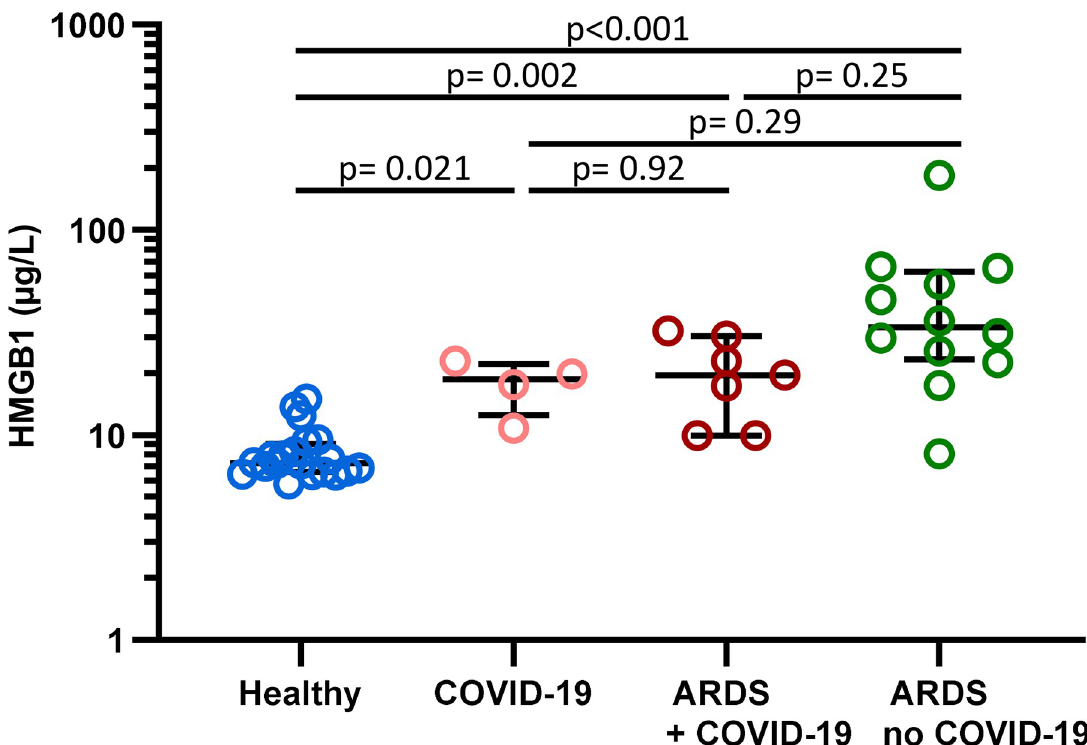
Fig 2. HMGB1 levels in healthy individuals, in COVID-19 patients with mild or severe course (ARDS) and in ARDS patients without COVID-19. HMGB1 levels were evaluated in healthy individuals (n = 20), COVID-19 patients with a mild (n = 4) course and ARDS (n = 7) respectively, as well as ARDS patients without COVID-19 (n = 12). Data are shown as median ± IQR. Kruskal-Wallis ANOVA with Dunn’s post-hoc test was performed. Abbreviation: ARDS, acute respiratory distress syndrome; COVID-19, Coronavirus disease 2019; HMGB1, high-mobility group box 1 protein; IQR, interquartile